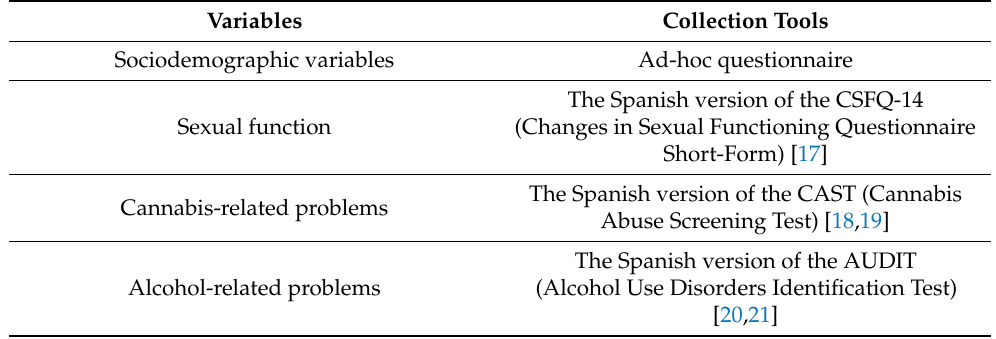
Table 1. Variables and data collection